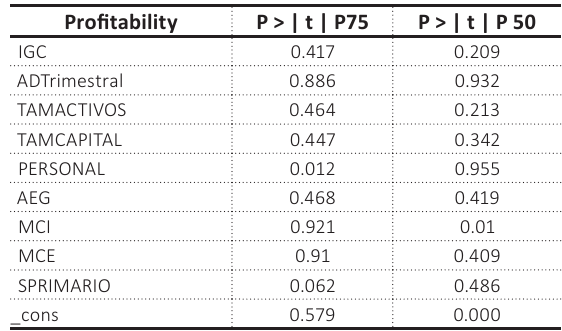
Table 8. Comparison of profitability estimates